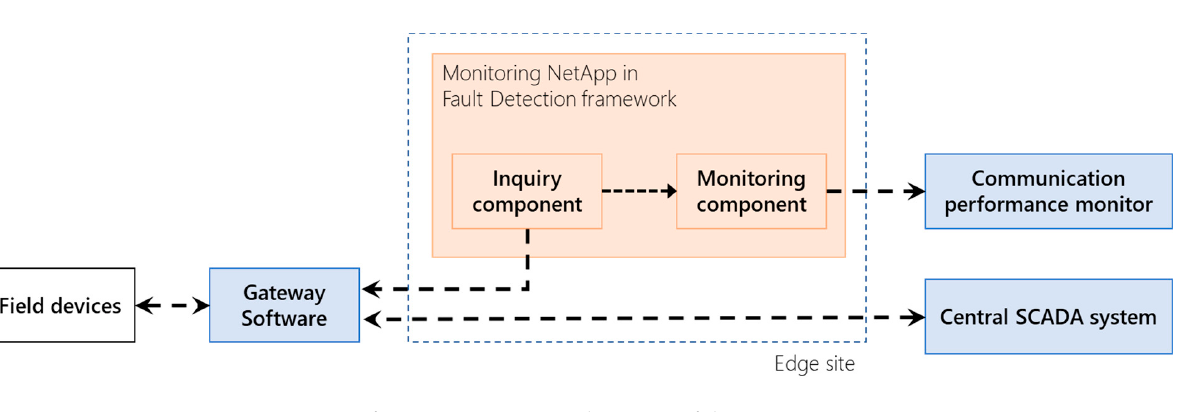
Figure 8. Site architecture of UC1. The MV protection devices and remote terminal units (RTUs) forward the collected data to the local gateway. Its purpose is to send them through the DSO telecommunication infrastructure to the central systems in order to ensure the remote control of the electric grid and, in the meantime, also ensure the interaction with other MV protection devices in the field, with the aim of automatically finding and isolating a fault on the grid when it